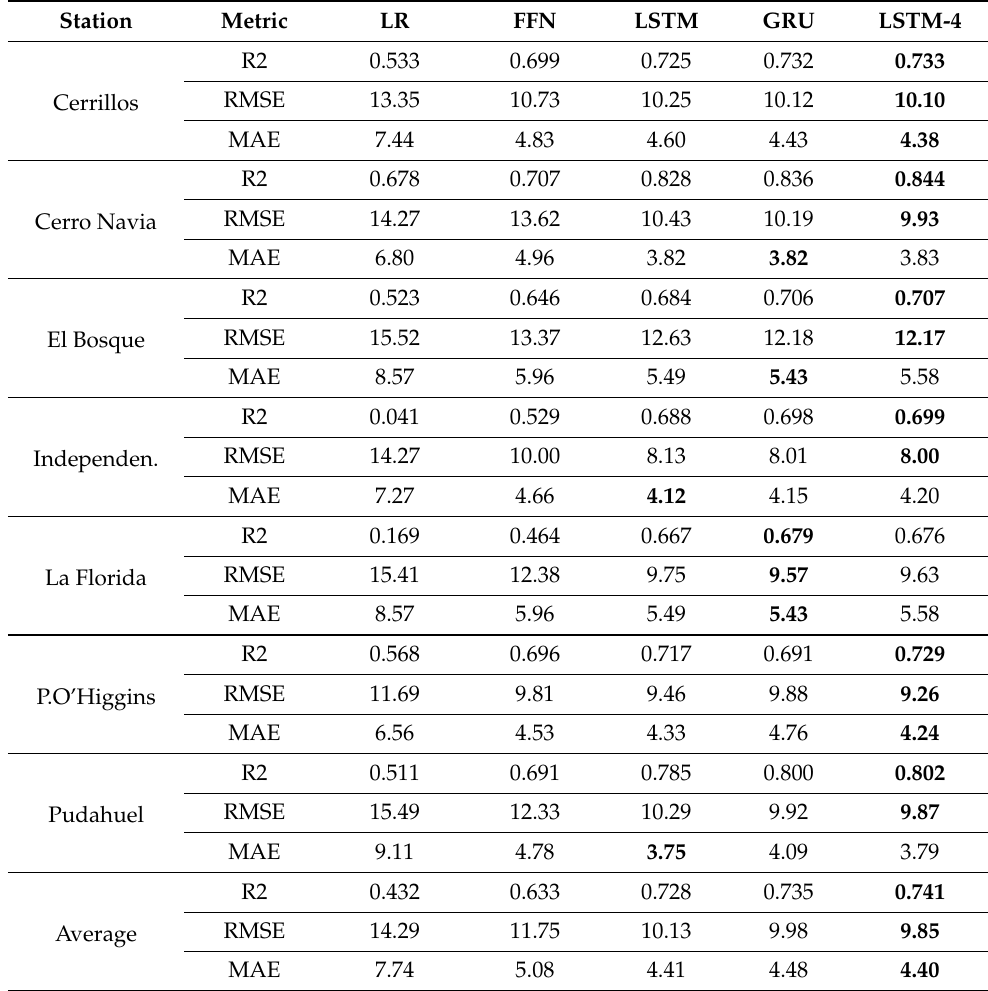
Table 7. Metrics of space-time predictions considering 7 stations, of 1 h in the future. Bold font indicates best